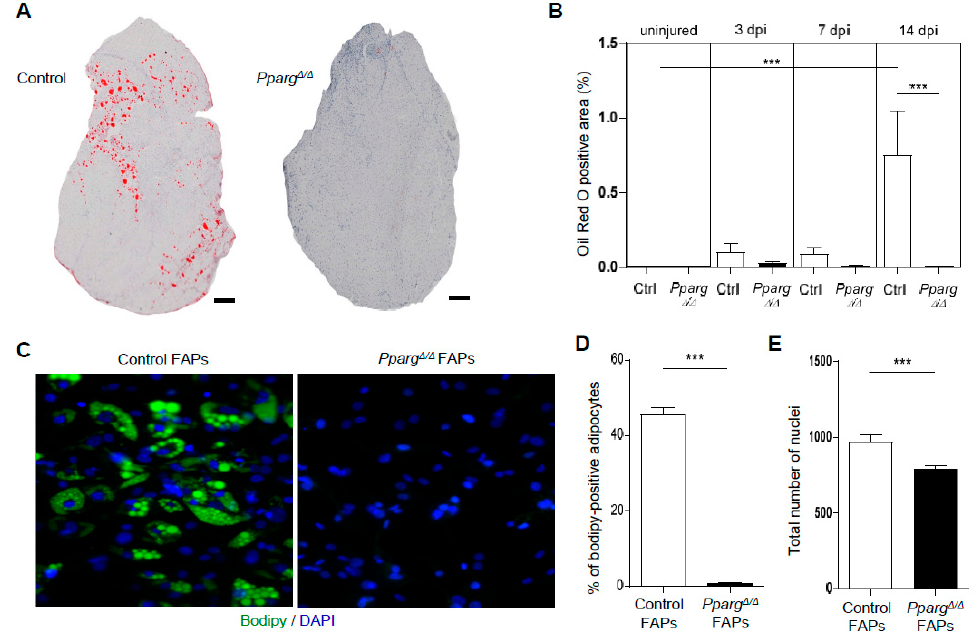
Figure 1. Ectopic adipogenesis during muscle regeneration is abolished in Pparg ∆ / ∆ mice. Tibialis anterior muscles from Pparg ∆ / ∆ and control littermates mice were injured with 50% glycerol intramuscular injection and collected at 3, 7, and 14 days post injury (dpi), n ≥ 7 mice per group. ( A ) Representative image of tibialis anterior (TA) section of control (Ctl) and Pparg ∆ / ∆ (KO) mice stained by Oil Red O at 14 dpi. Scale bars: 200 µ m. ( B ) Quantification of the area covered by Oil Red O in uninjured muscle and at 3, 7, and 14 dpi in control and Pparg ∆ / ∆ . ( C – E ) FAPs were isolated from control and Pparg ∆ / ∆ muscle by flow cytometry and cultured in adipogenic conditions, with n ≥ 24 cell culture replicates pooled from at least three mice per genotype and replicated twice on different days. ( C ) Representative staining of lipid droplets by bodipy (green) and DNA (blue). Magnification: 20 × objective. ( D ) Percentage of differentiated Bodipy-positive FAPs quantified by high content imaging. ( E ) Total number of FAPs quantified by high content imaging via the DAPI staining. *** p < 0.001 by one-way analysis of variance (ANOVA) followed by Bonferroni’s test ( A ) and by Mann–Whitney test ( D , E ).